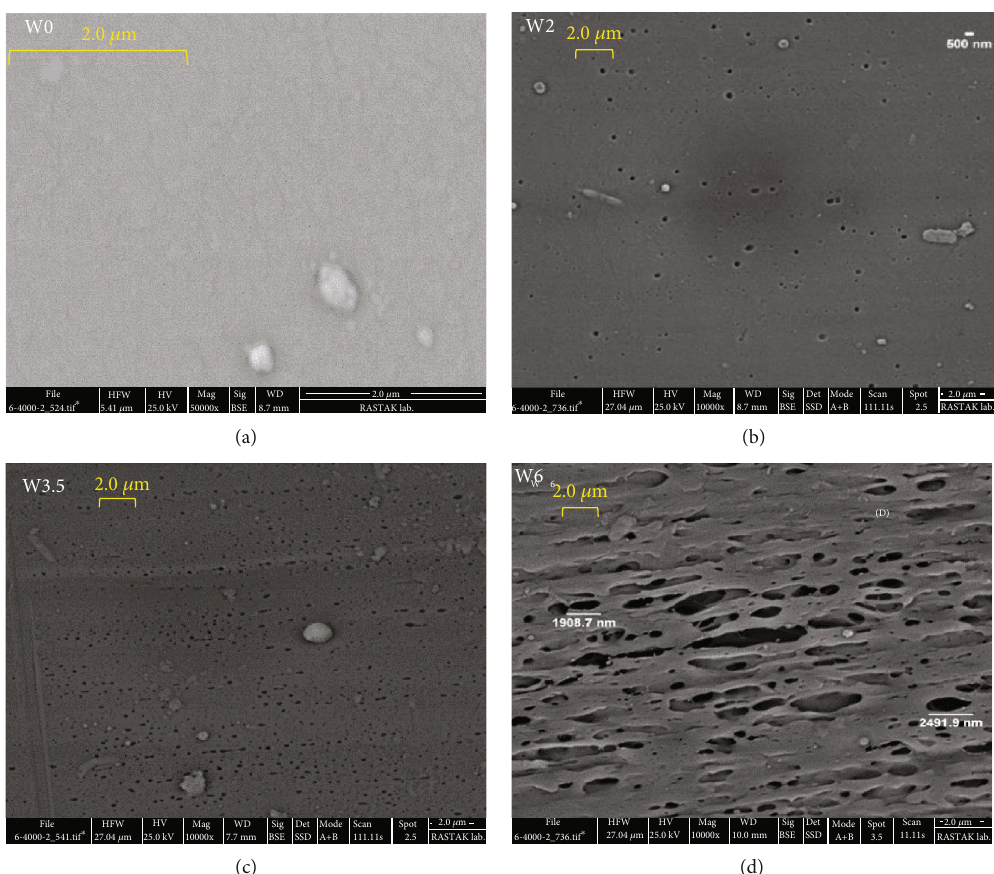
Figure 3: The membrane outer surface morphology of PAN hollow fi ber membranes spun from di ff erent H (b) 2wt%; (c) 3.5wt%; (d) 6